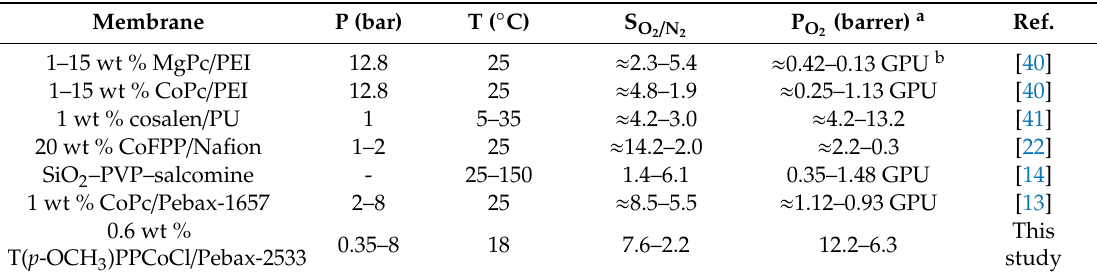
Table 1. Comparison of the separation performance of the reported membranes with this